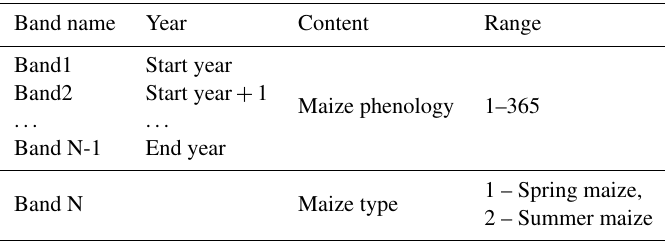
Figure 13. The spatial distribution of maize across the study area (a) and pixel values represent the coverage of maize in 1km and (b) and (c) indicate the coverage of spring and summer maize. Additionally, we also provided the proportion of maize in major agricultural zones. The mean temperature and mean annual total precipitation during the growing period of the crop (from May to October) from 2011 to 2020 are presented in (d) and (e) . (f) and (g) show the kernel density curves of the mean temperature and mean annual total precipitation in the study area. The abbreviations are as follows: NCP: Northeast China Plain; LP: Loess Plateau; Nor: northern arid and semiarid region; HHH: Huang-Huai-Hai Plain; MLYP: middle-lower Yangtze Plain. Table 1. Detailed band information in each